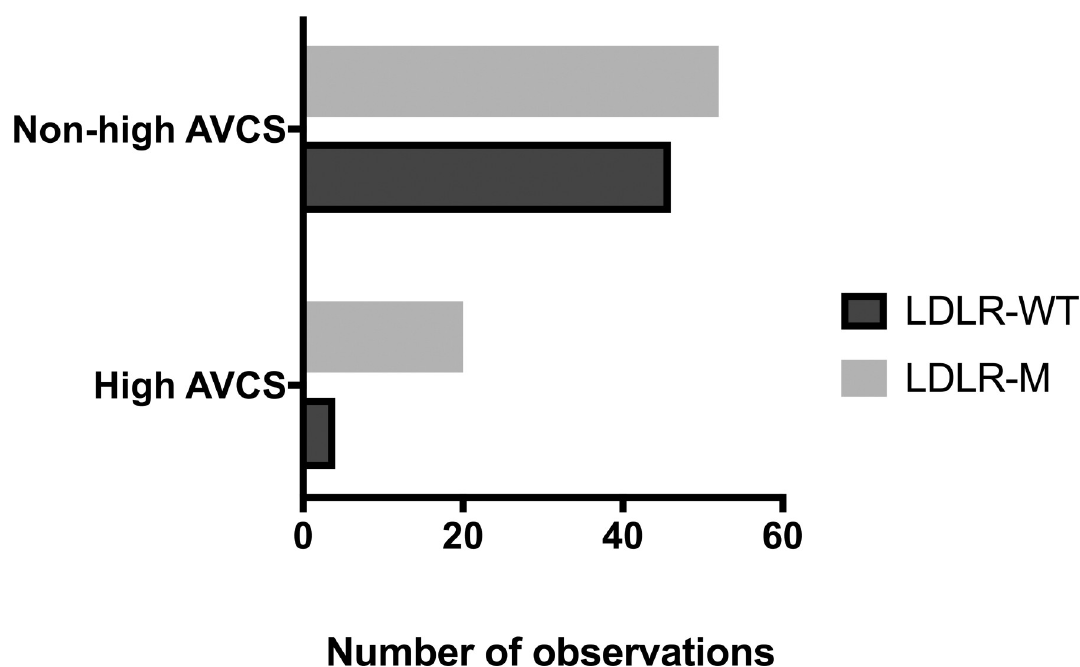
Fig 4. Histogram of the contingency table of patients with high and non-high AVCS. Abbreviations: LDLR-M–patients with familial hypercholesterolemia and LDLR mutation, LDLR-WT–nonfamilial hypercholesterolemia, high AVCS–patients with high aortic valve calcium score, non-high AVCS–remaining patients.